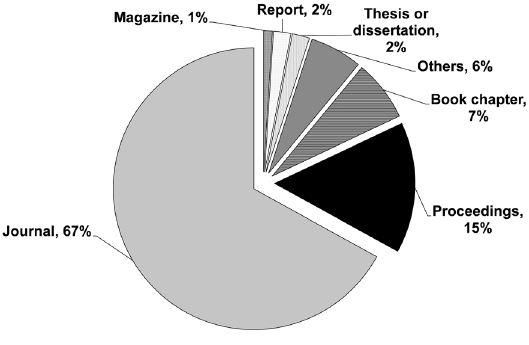
Figure 2 - Temporal trend of the 498 screened publications on citizen science from 2005 to